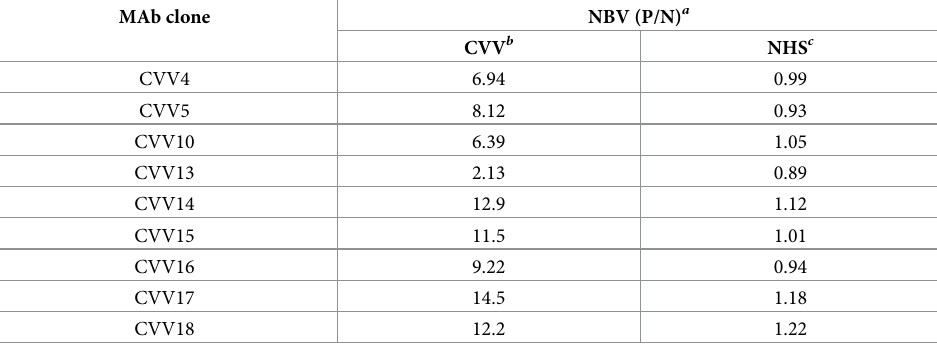
a NBV (nonspecific background values) were determined by calculating the ratio of the mean OD containing CVV (P) divided by the mean OD 450 of the wells without virus (N) for each serum sample. b human serum sample positive for CVV neutralizing Ab. c pooled negative human serum